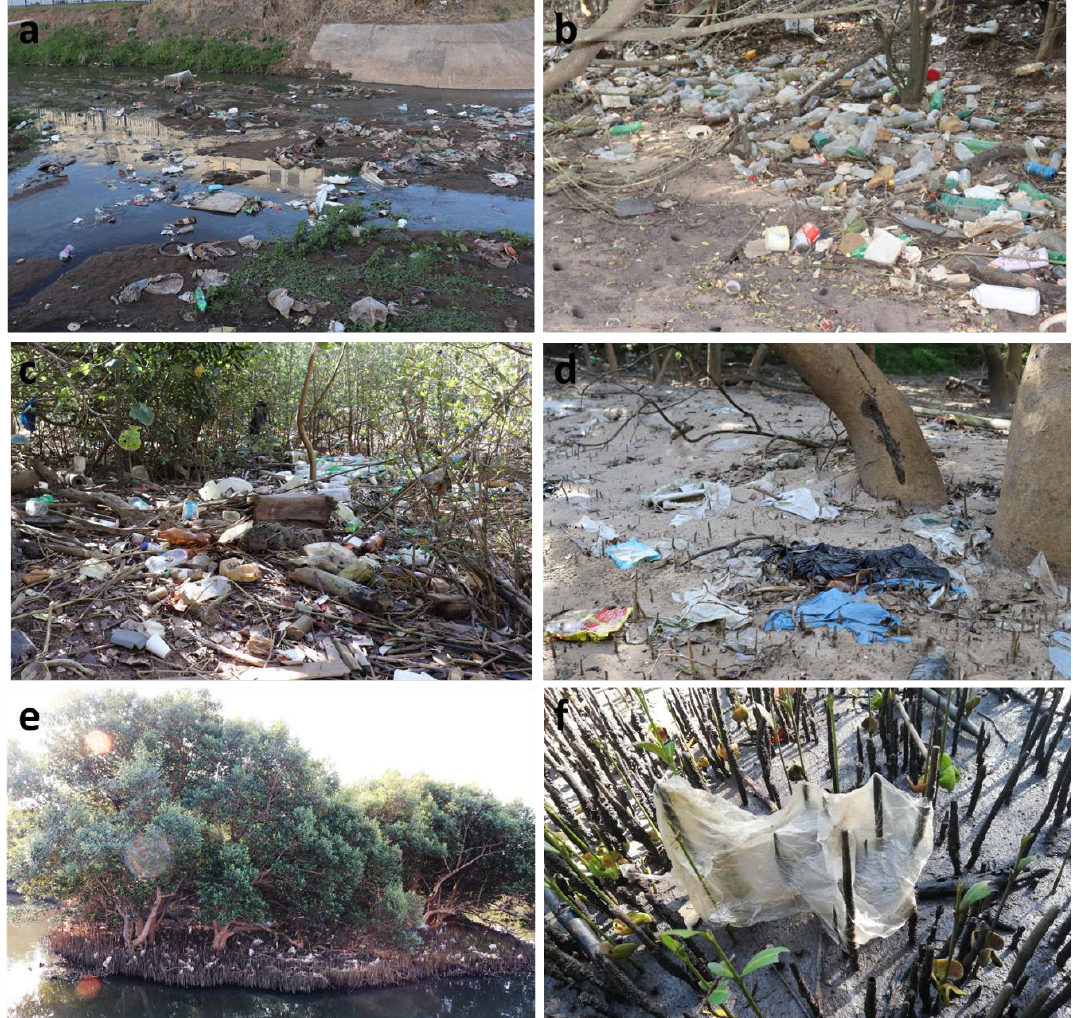
Figure 3. Evidence of macroplastic pollution found ( a ) upstream from the sampling site at Isipingo; ( b ) within the mangrove stand at Isipingo; ( c ) within the mangrove stand at uMgeni; ( d ) within the mangrove stand at Durban Harbour; ( e ) trapped within fringing pneumatophores at Isipingo; and ( f ) covering pneumatophores at Durban Harbour. Table 2. Polymer composition of a subset (n = 77) of the microplastic particles encountered in sediment and water at the four estuaries sampled based on morphology.